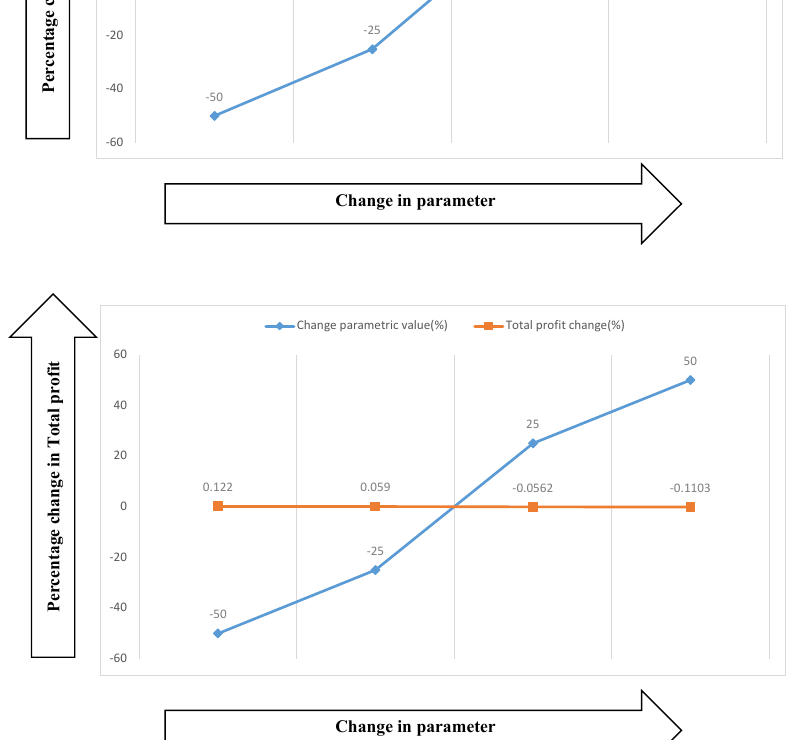
Figure 6. Changes in parameters O C